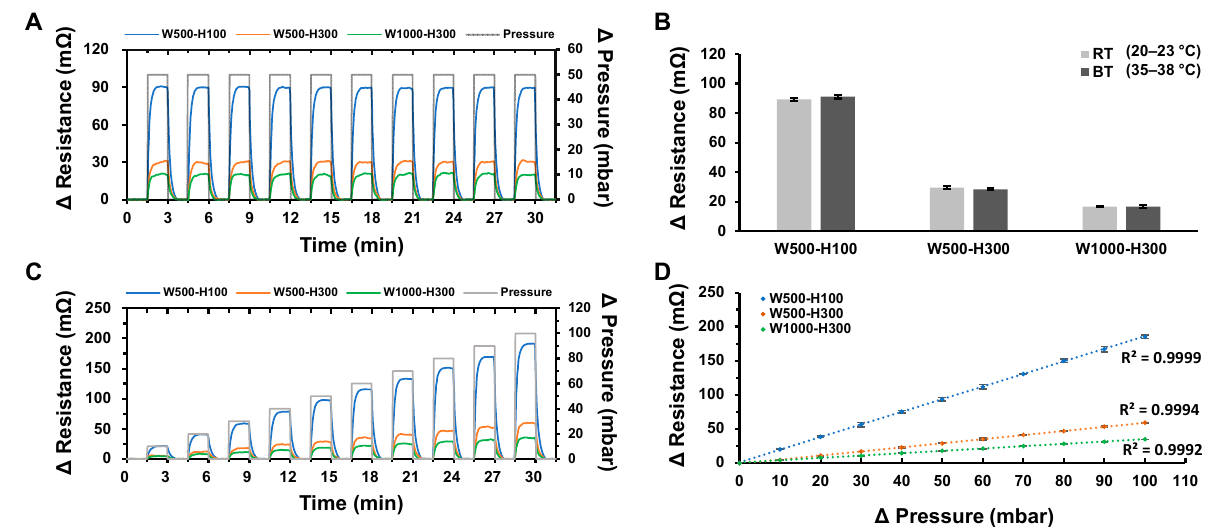
Figure 5. ( A ) Change of the electrical resistance in accordance to the periodic pressure changes ( n = 3). ( B ) Comparison of the Δ R measurements at two different temperatures (RT = 23–25 °C, BT = 35–38 °C). ( C ) Change of the electrical resistance in accordance to the incremental pressure changes ( n = 3). ( D ) Graph showing the linearity between the applied pressure and the measured electrical resistance ( n = 3).